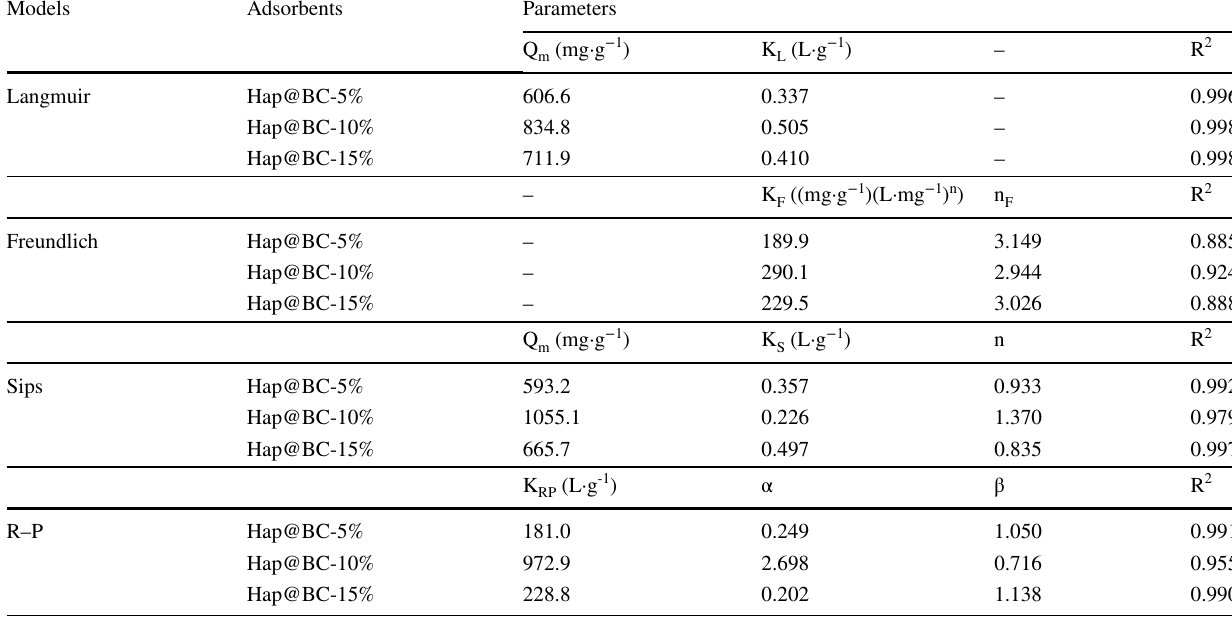
Table 2 Fitting parameters for isotherm adsorption models